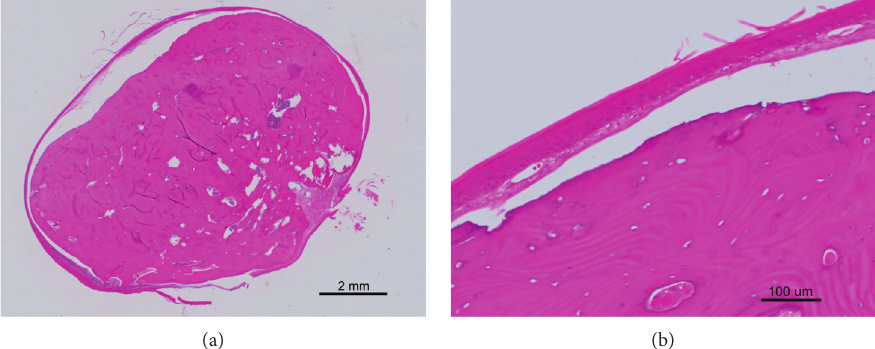
Figure 3: Histopathologic images. (a) Histologic examination shows well-circumscribed bone tissue (H&E × 20). (b) Mature bone is surrounded by fibrous connective tissue and covered with stratified squamous epithelium (H&E ×